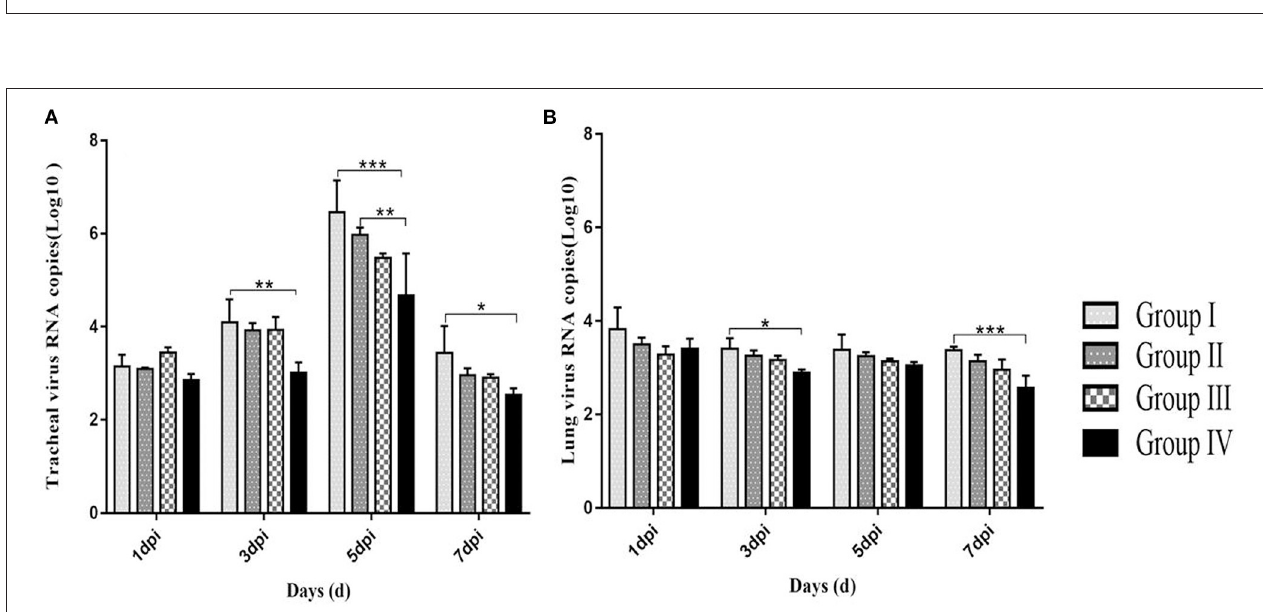
FIGURE 5 | HE staining to delineate the relieve effect of SGDL granule combined with doxycycline on IBV-induced lung histopathogic changes (magnification, × 200). Group I served as a control. Broilers in Group II were given doxycycline whereas Group III was given SGDL granule through drinking water. Broilers in Group IV were given SGDL granule and doxycycline in drinking water. It was intraocularly and intranasally challenged by IBV at day 28. e indicates parabroncheal lumen. Red arrow: congestion; blue arrow: lymphoid cell. SGDL, Shegandilong; HE, hematoxylin–eosin.